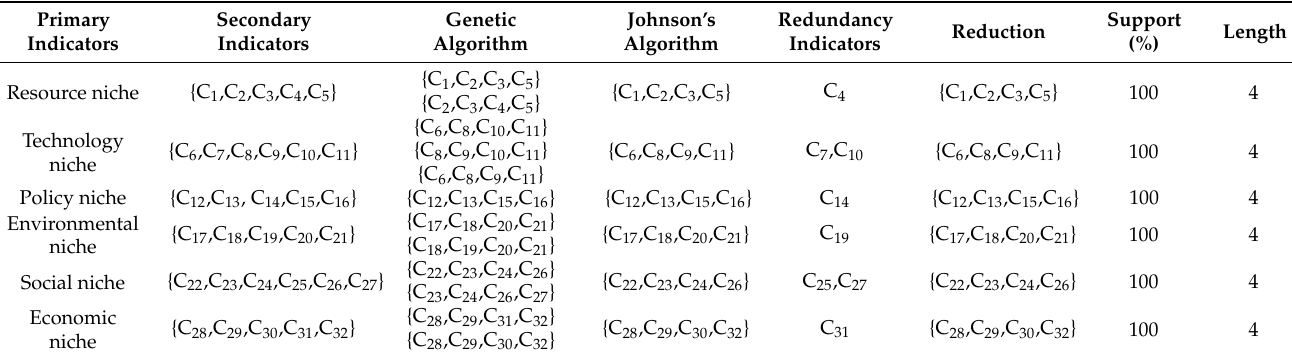
Table 3. Results of attribute reduction.